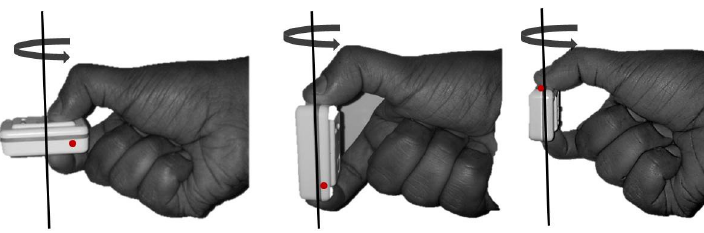
Figure 8. AHRS rotation used for removing hard iron offsets.